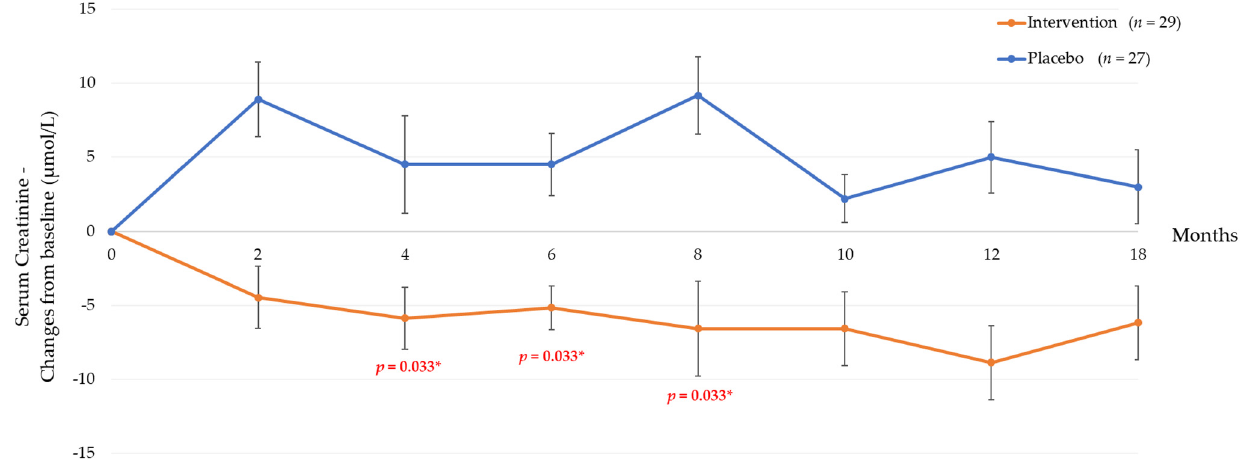
Figure 3. Changes in serum creatinine in intervention and placebo group throughout the study period of 18 months. Data are presented as mean ± standard deviation. * Significant at p < 0.05.